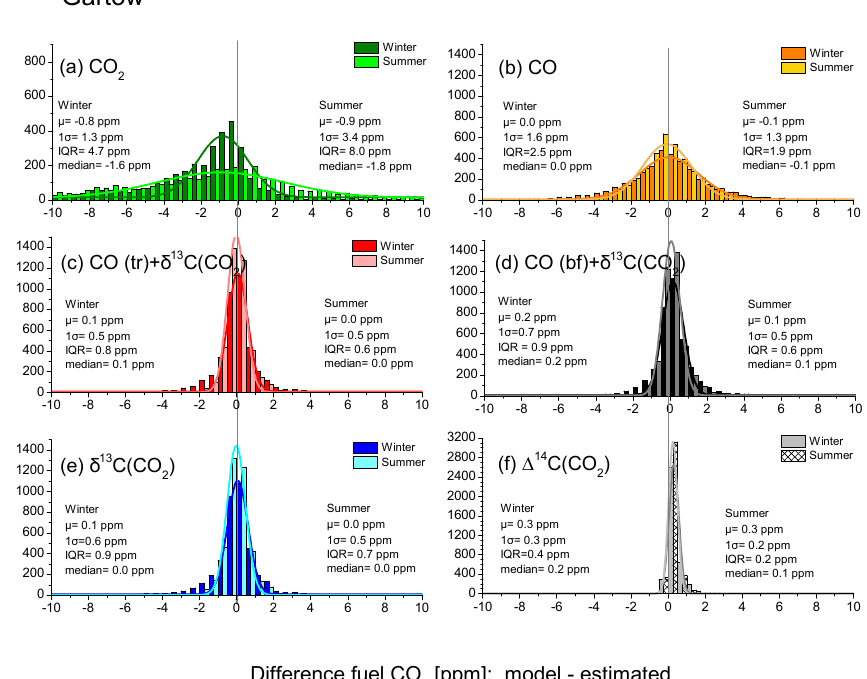
Figure 2. Same as Fig. 1 but for Gartow. In Gartow, mean fuel CO 2 for summer is 2µmolmol − 1 and that for winter is 4µmolmol − 1 .